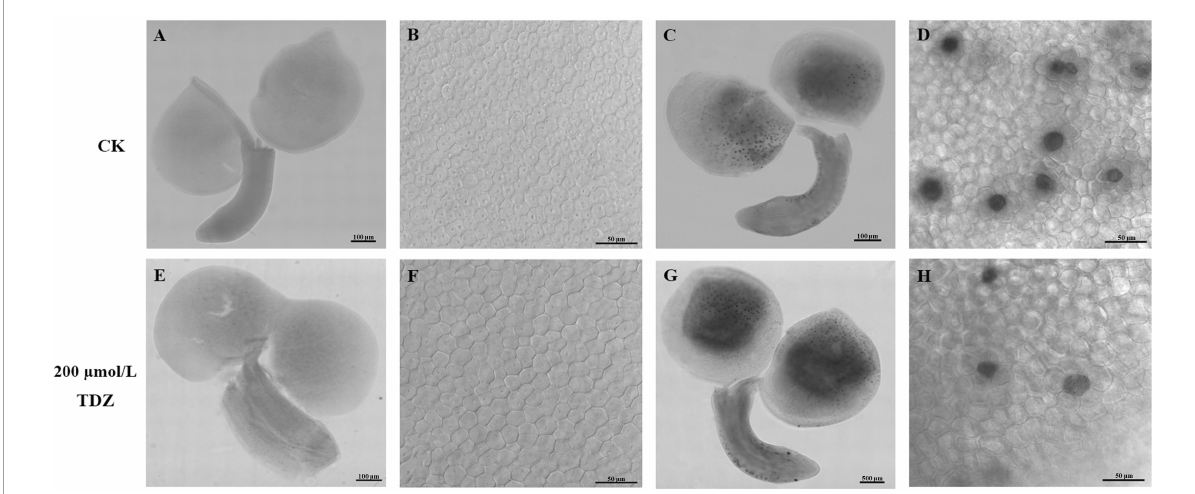
FIGURE3 Effect of TDZ treatment on embryo cell size and number. (A,E) Immature embryos from seeds of 20 days after treatments; (B,F) epidermal cell layer from the central part of cotyledons from panels (A,E) ; (C,G) mature embryos from mature dried seeds; (D,H) epidermal cell layer from the central region of cotyledons panels (C,G) . Scale bar: 100 µ m in panels (A,C,E) and 500 µ m in panel (G) , observation with 20 × objective in DIC mode; 50 µ m in panels (B,D,F,H) , 40 × oil lens observation in DIC mode.